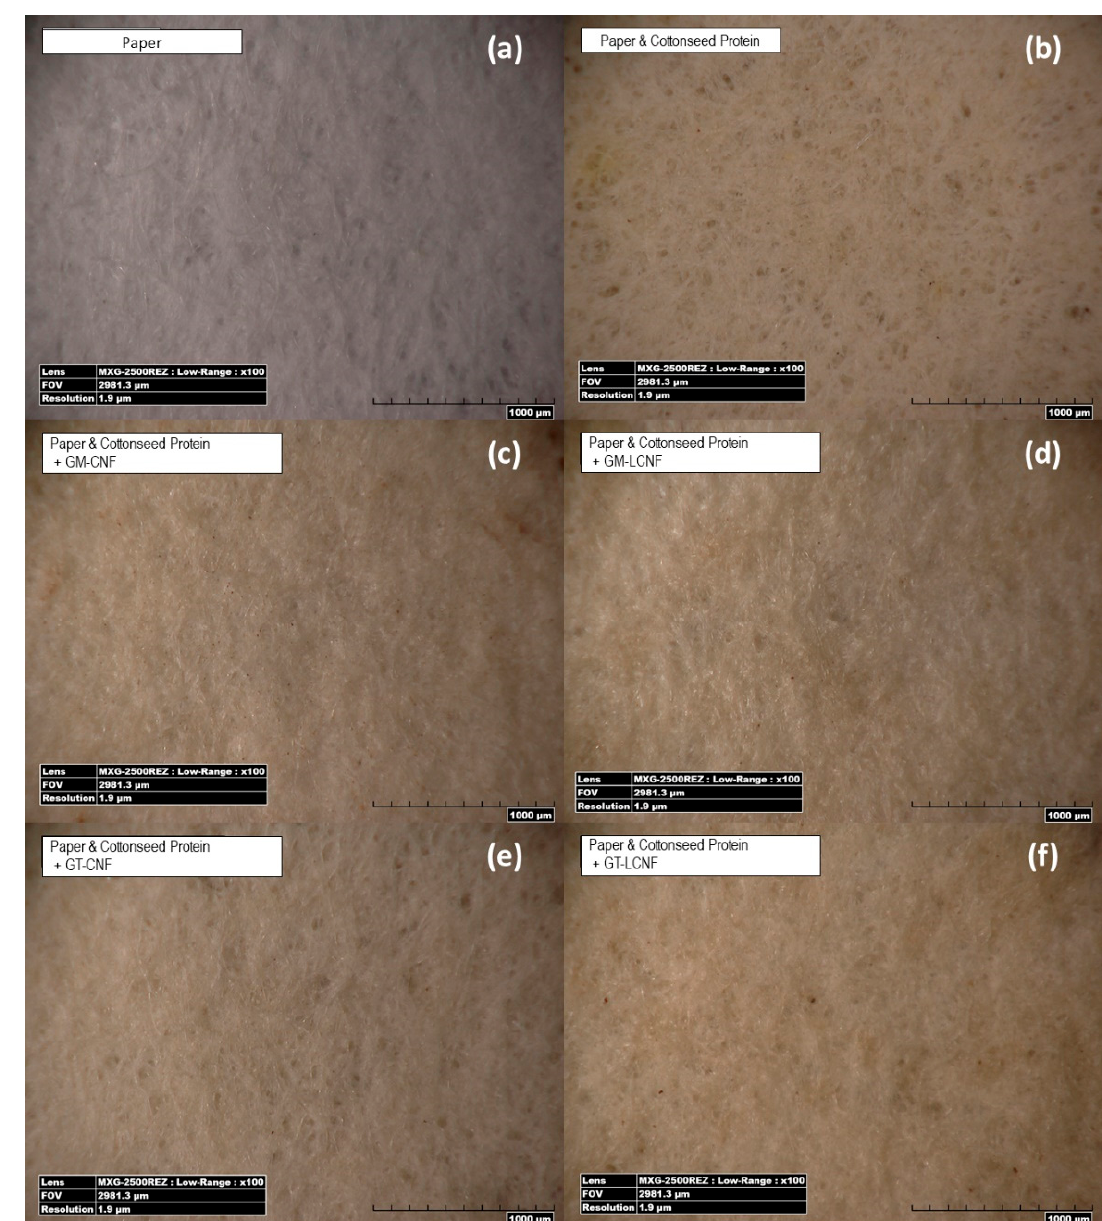
Figure 2. Optical microscopy images (100× magnification) of ( a ) control paper and paper treated with ( b ) cottonseed protein isolate (CSP); ( c ) CSP and GM-CNFs; ( d ) CSP and GM-LCNFs; ( e ) CSP and GT-CNFs; and ( f ) CSP and GT-LCNFs.